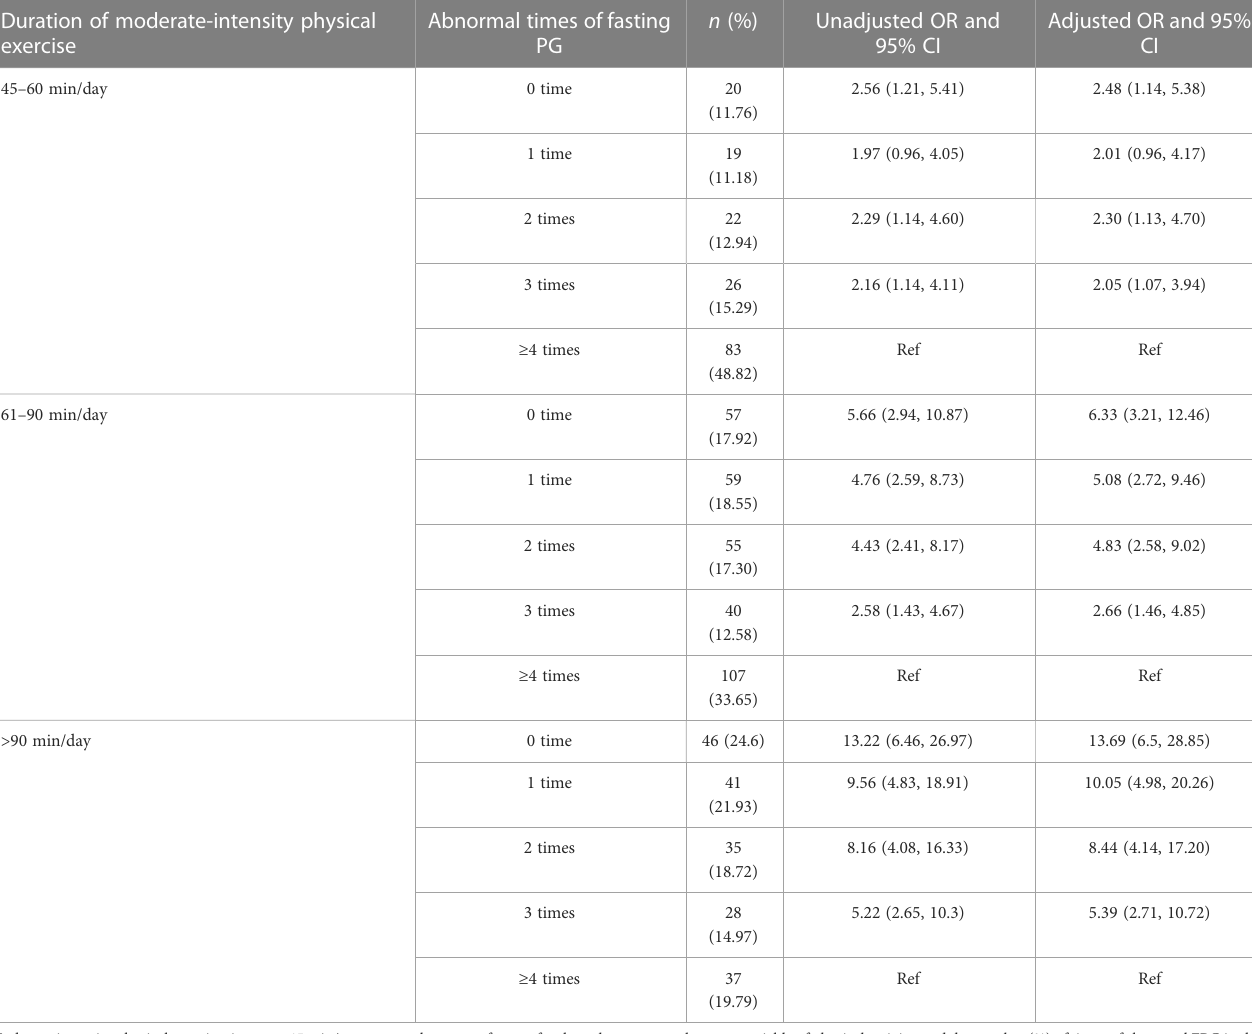
TABLE 1 The association between daily physical exercise duration and the number of abnormal fasting plasma glucose (FPG) occurrences in women with GDM ( n = 878). Duration of moderate-intensity physical exercise